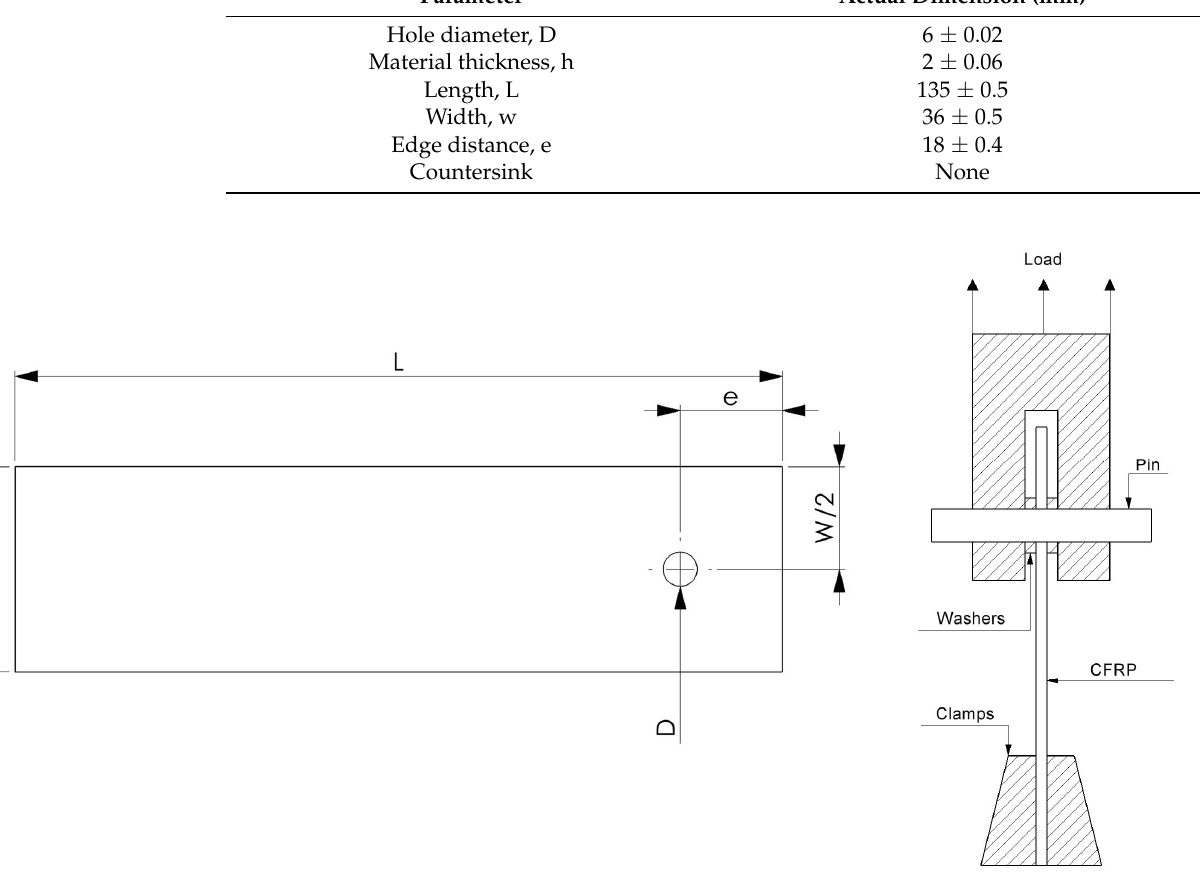
Figure 3. Schematic diagram of specimen and pin-load setup for the bearing strength